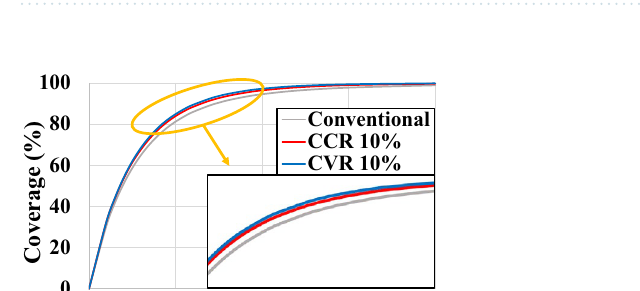
Figure 11. Mass flow rate according to models.